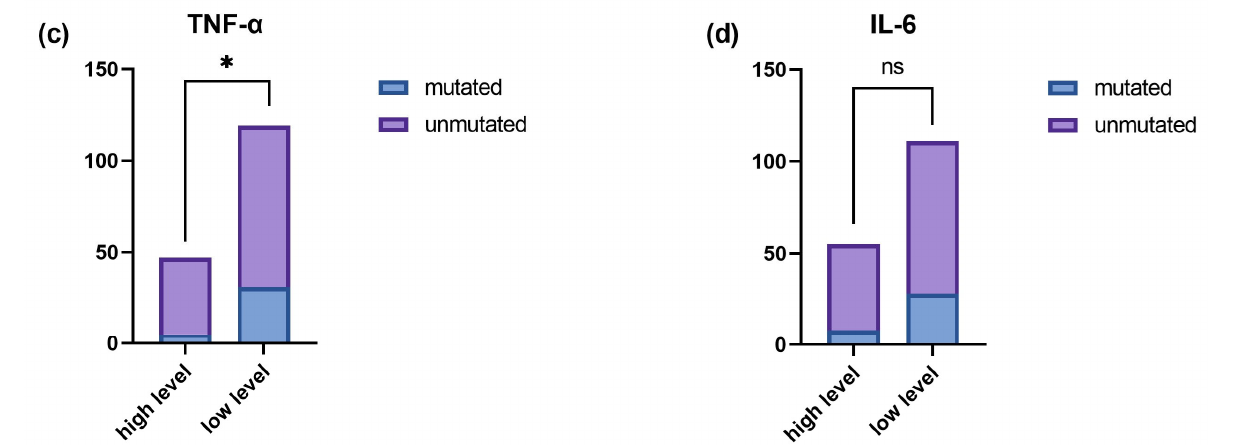
Figure 2. Comparison of IL-6 and TNF- α levels between p.R4810K mutated and unmutated in RNF213. ( a , b ) are the differences between the mutation group and the non-mutation group when TNF- α and IL-6 were analyzed as continuous variables. ( c , d ) are the differences between the mutation group and the non-mutation group when TNF- α and IL-6 are divided into a high-level group and a low-level group for analysis. ns, no significance; * p < 0.05.